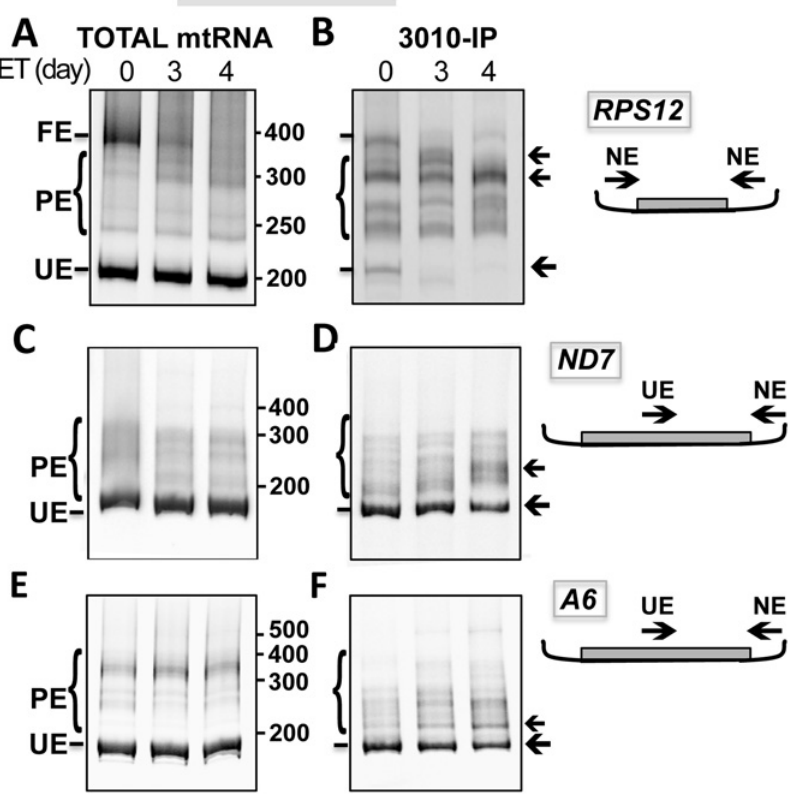
Fig 6. REH2 knockdown decreased substrate loading and increased pausing during editing in 3010-MRB. Endpoint RT-PCR products in total mtRNA and 3010-IPs at 0, 3, and 4 days of REH2 RNAi. mRNAs RPS12 (A and B), ND7 (C and D) or A6 (E and F). The full editing domain in RPS12 or a 3 ’ fragment of similar size in ND7 and A6 was amplified. Products of varying sizes are unedited (UE), partially edited (PE), or fully edited (FE), in the case of RPS12. Arrows point to regions of apparent major pausing induced by REH2 depletion. The primers target 5 ’ unedited (UE) or 3 ’ never-edited (NE) sequences, as depicted in the